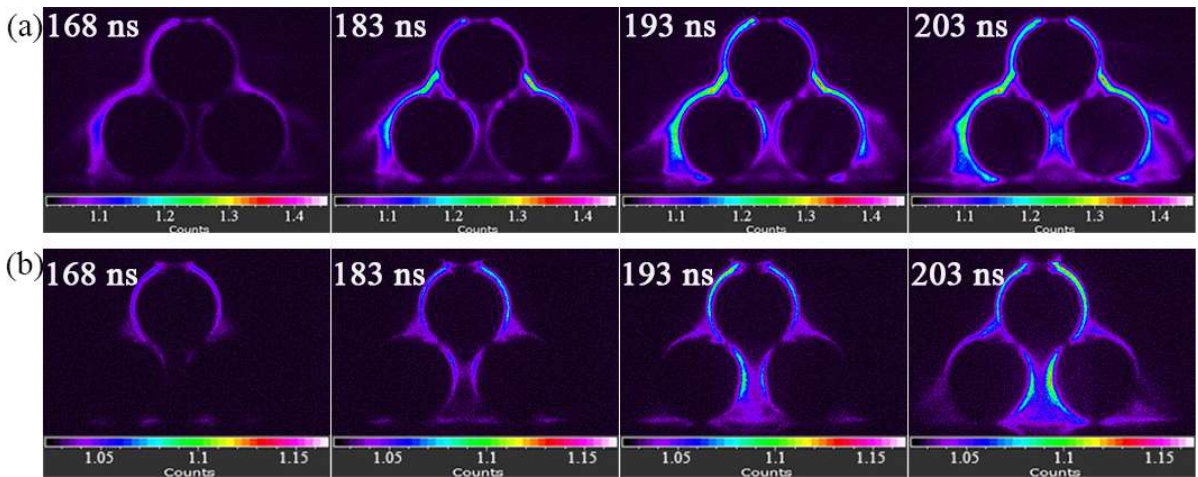
Figure 8. ICCD images of the discharge evolution processes during the falling time of the voltage pulse in ( a ) pure nitrogen and ( b ) air.